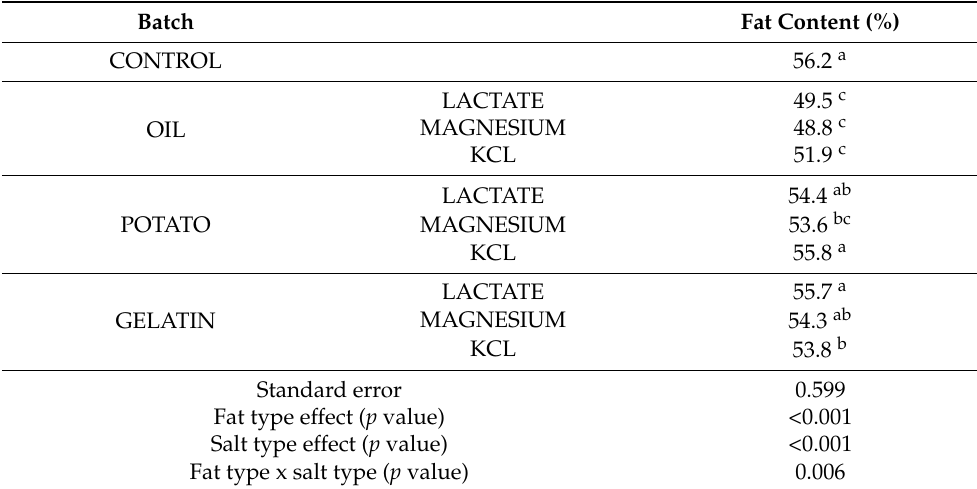
Table 2. The means and standard error for fat amount of 10 experimental batches of dry-fermented sausages and the p values for studied effects (fat type and salt type).